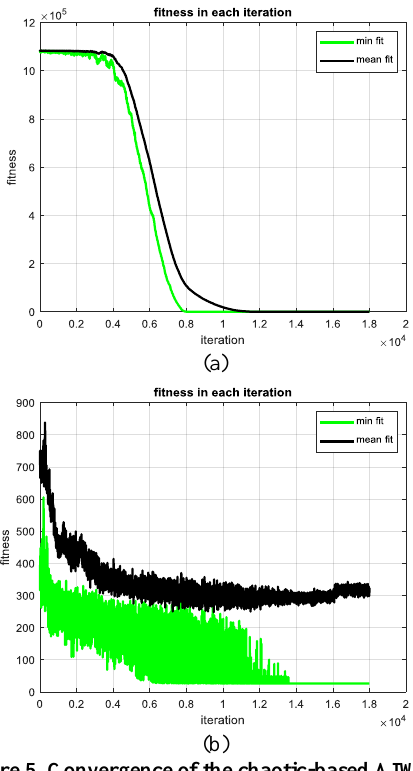
Figure 5. Convergence of the chaotic-based AIW-PSO with Lorenz system for two sample functions (a) f 2 (b) f 11 .